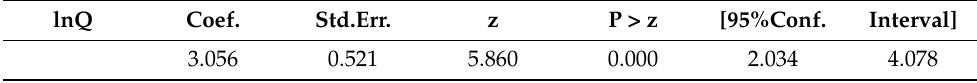
Table A2. The constant return to scale (CRS) hypothesis test